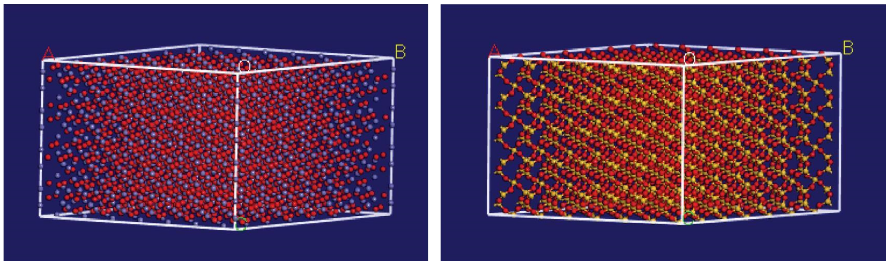
Figure 4: Crystal models of Fe